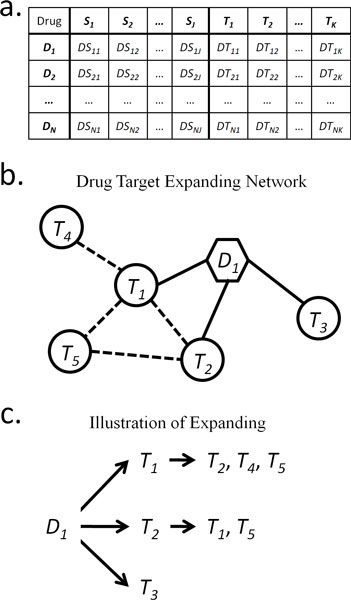
Format of ADR vs. drug target facts and an example of drug target expanding network. a) This figure shows the format of ADR vs. drug target facts. Dn, Si, and Tj mean drug n, ADR i, and target j respectively. b) This figure is an example of a drug target expanding network. The dotted lines mean PPIs. c) This part illustrates the process of the drug target expanding one level in PPI network. T1, T2, and T5 are present twice in all branches of this expanding "tree", thus the values in cells DT11, DT12, and DT15 in ADR vs. drug target facts are all 2; the rest, including DT13 and DT14, are both 1.